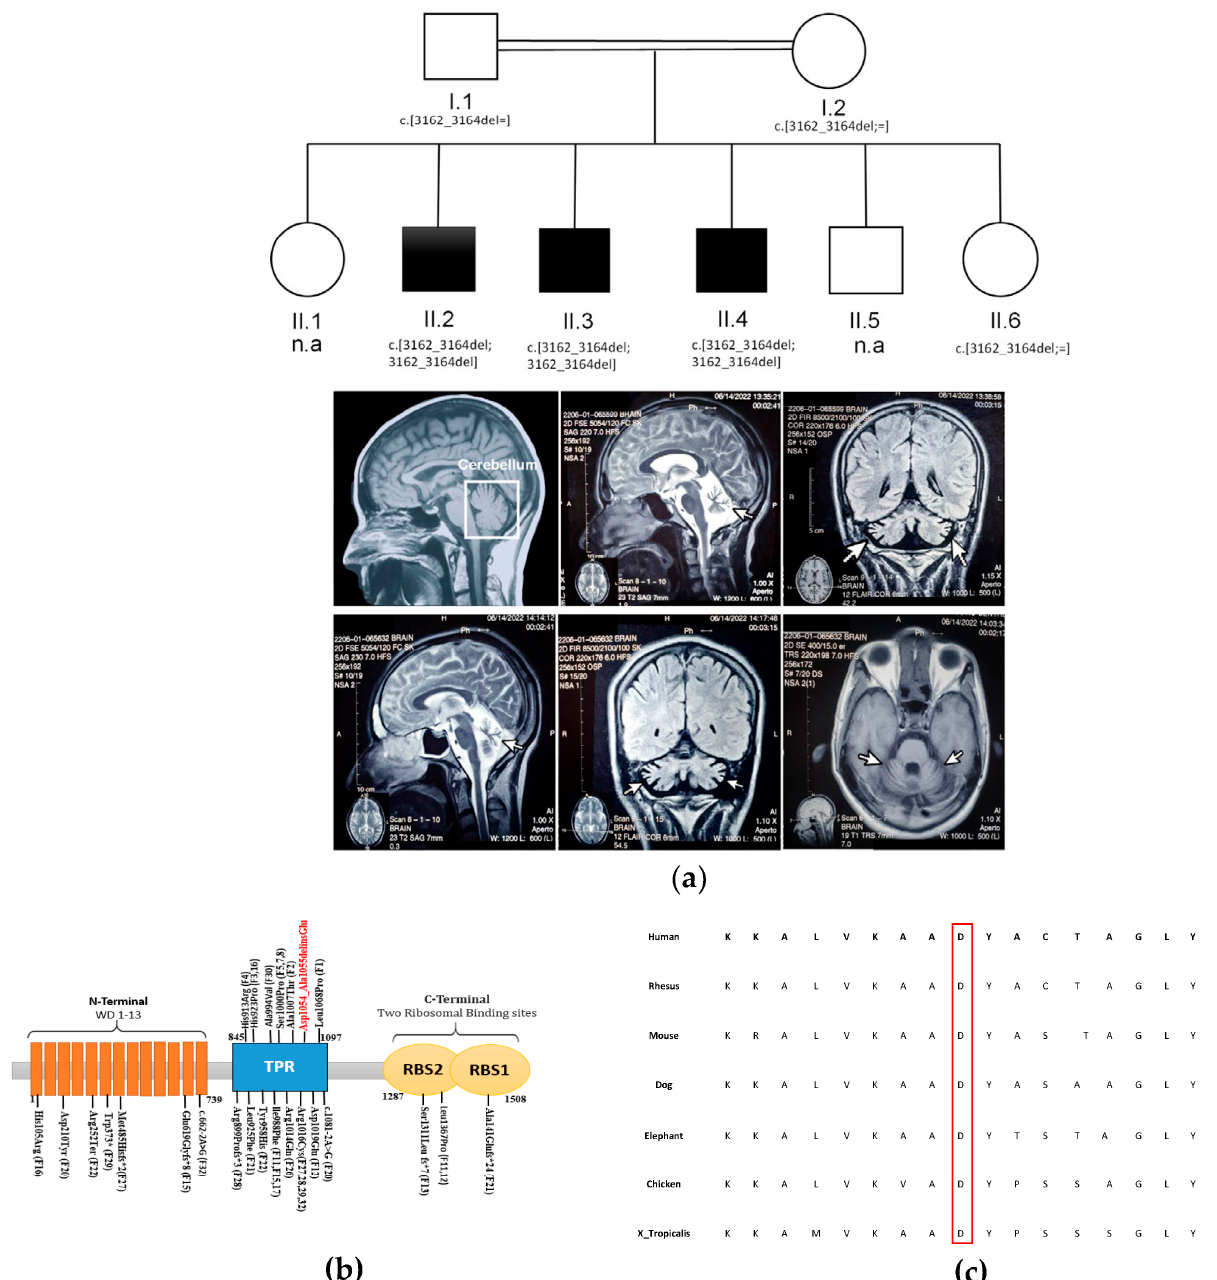
Figure 1. NM_015465.5 (NP_056280.2):p. (Asp1054_Ala1055delinsGlu) deletion in GEMIN5 in three Figure 1. siblings. ( a ) On the top is the family pedigree with the 3bp-deletion variant genotype of individuals. On the bottom, brain MRI of normal individual (on the top left sagittal view), II.2 (on the top center sagittal view and on the top right frontal) and II.4 (on the bottom left sagittal view, in the bottom center the frontal, and on the bottom right the axial view) showing characteristic cerebral atrophy (white arrows) in patients carrying three base pair deletion NM_015465.5:c.3162_3164del; NP_056280.2: p.Asp1054_Ala1055delinsGlu) in GEMIN5 . ( b ) Schematic representing functional domains and position of NM_015465.5 (NP_056280.2):p. (Asp1054_Ala1055delinsGlu) (highlighted as red) and previously reported biallelic variants (highlighted as black). Family numbering is given for previously reported variants. ( c ) Alignments of protein sequence across different species representing high conservation of the deleted NM_015465.5 (NP_056280.2):p. (Asp1054_Ala1055delinsGlu) identified in the three brothers, highlighted in the red